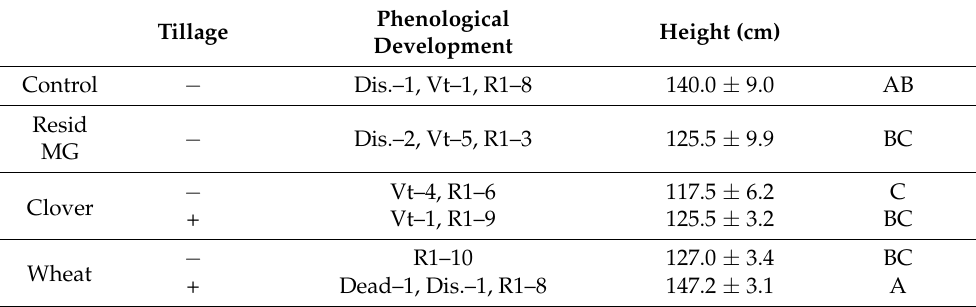
Table 2. The 2019 soil microbiome integrity experiment—growth parameters at 56 DAS 1 . Tillage